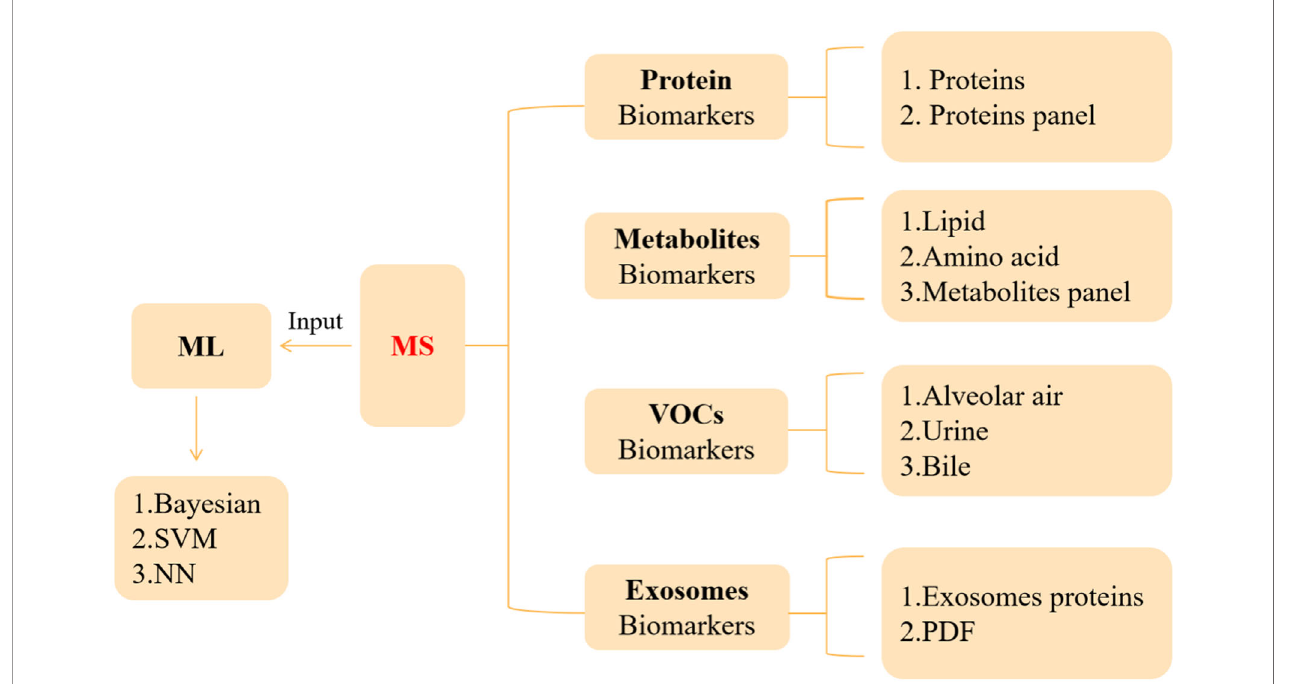
FIGURE 1 | Application of MS in the diagnosis and prognosis of